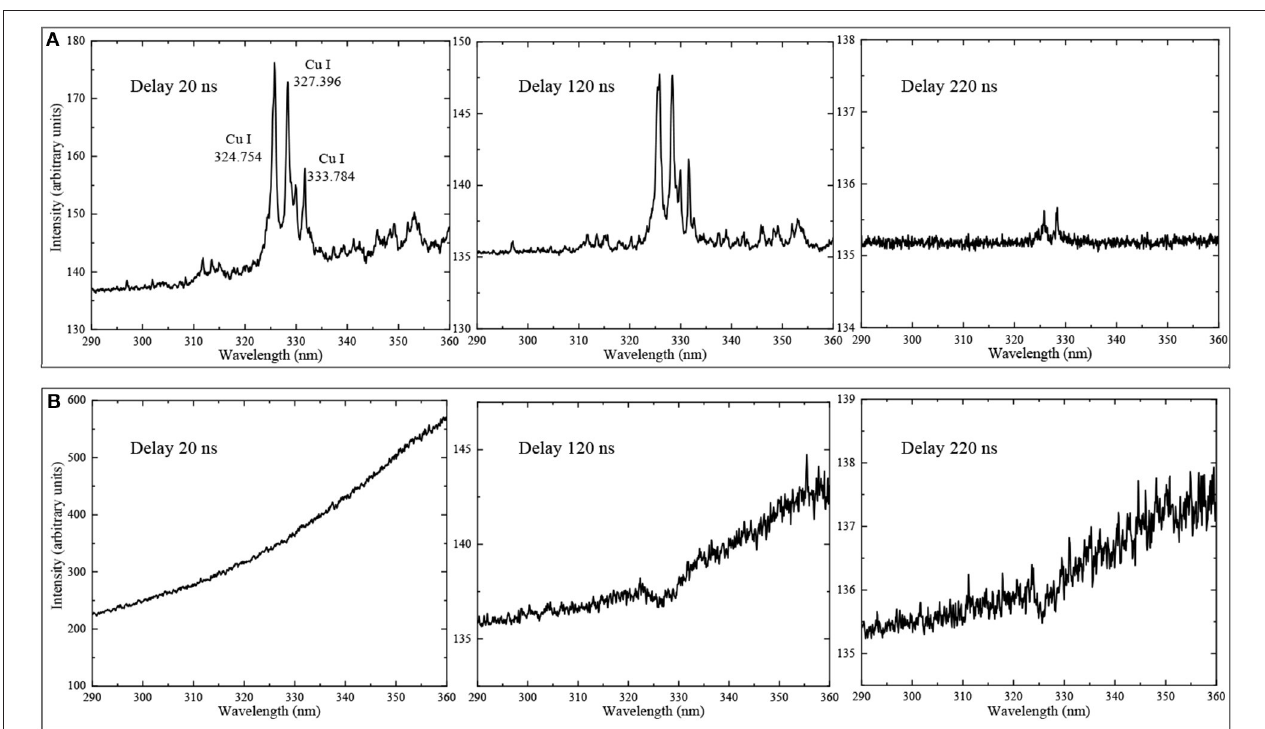
FIGURE 6 | 1-Shot spectra of underwater Cu sample in different delays. (A) Collinear LS-DP-LIBS and (B) conventional SP-LIBS. Experimental conditions: gate width: 100 ns, accumulation: 1